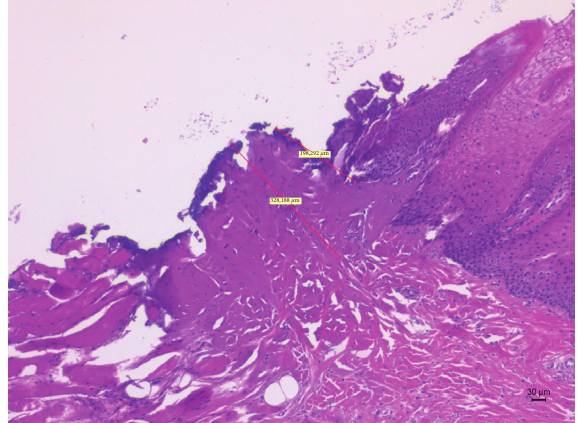
Figure 7: The histological specimen obtained using 6W in PW with colour EE at 10x magnification (group